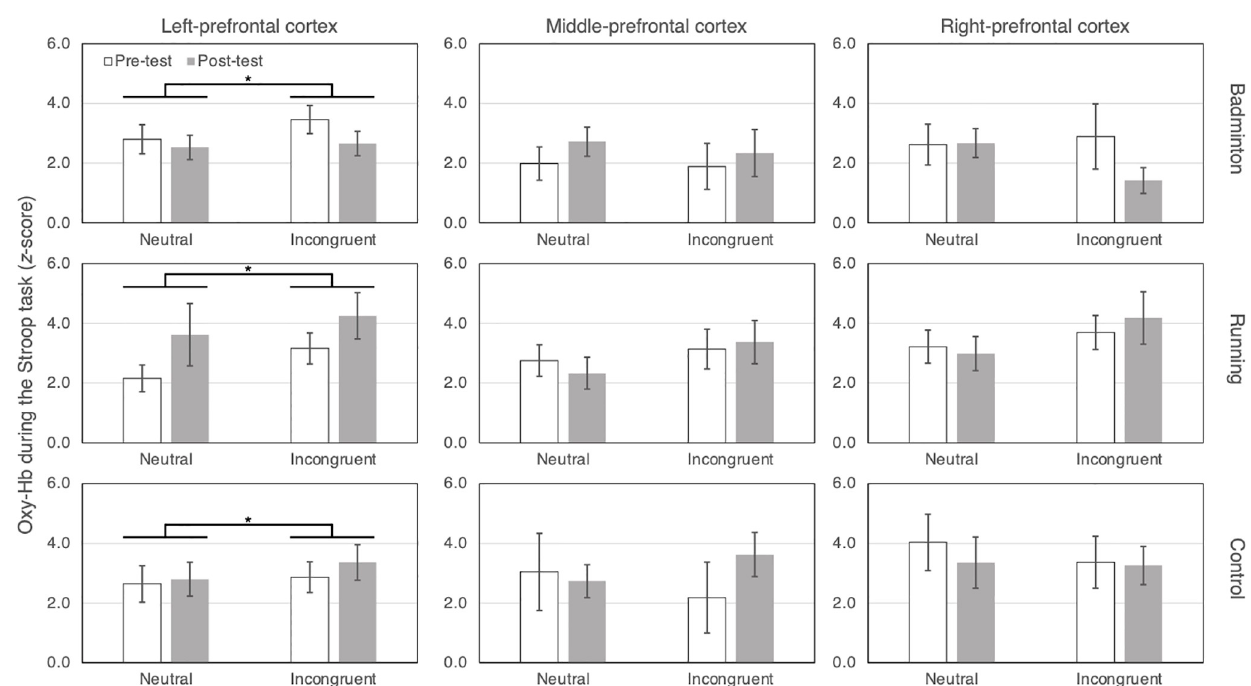
Fig 4. Comparisons of the oxygenated hemoglobin (z-score) for each intervention and region of the prefrontal cortex. White bars represent oxygenated hemoglobin at pre-test. Gray bars represent oxygenated hemoglobin at post-test. Error bars show standard errors of the mean. � means the significant difference between the neutral and incongruent conditions ( p < .05) for the left-prefrontal cortex throughout all interventions.